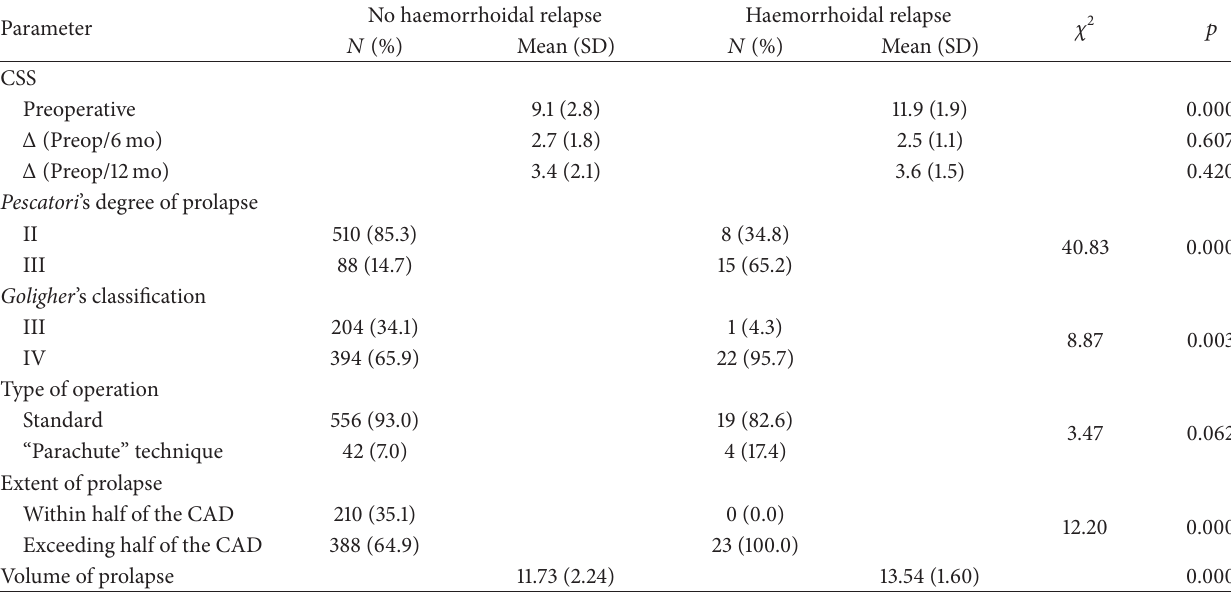
Table 6: Univariate analysis in patients with and without hemorrhoidal